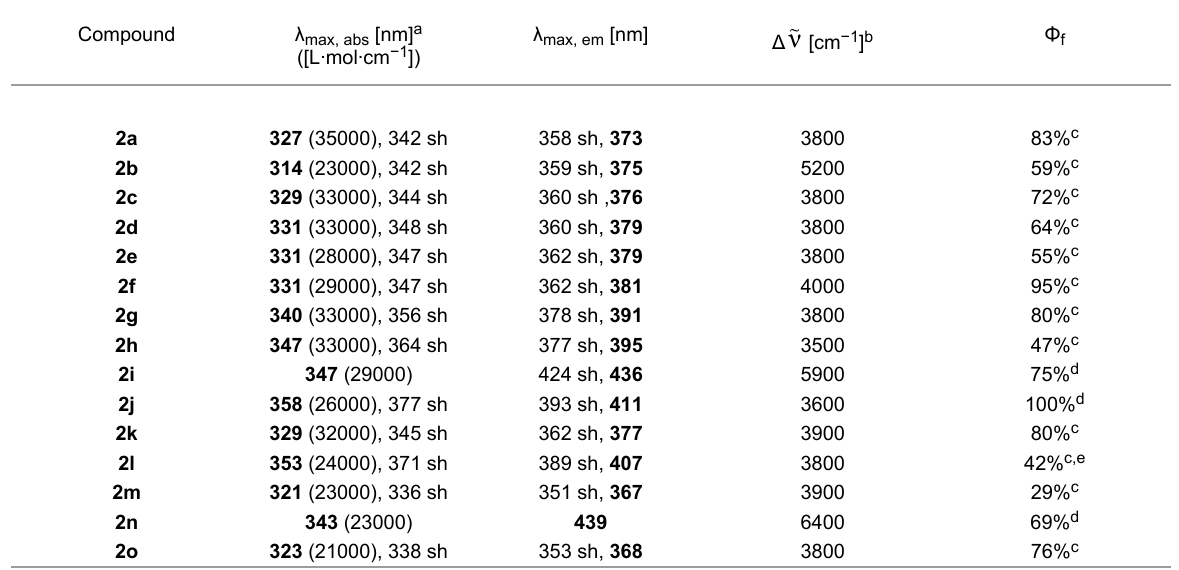
Table 2: Selected absorption and emission data (recorded in dichloromethane at T = 293 K).